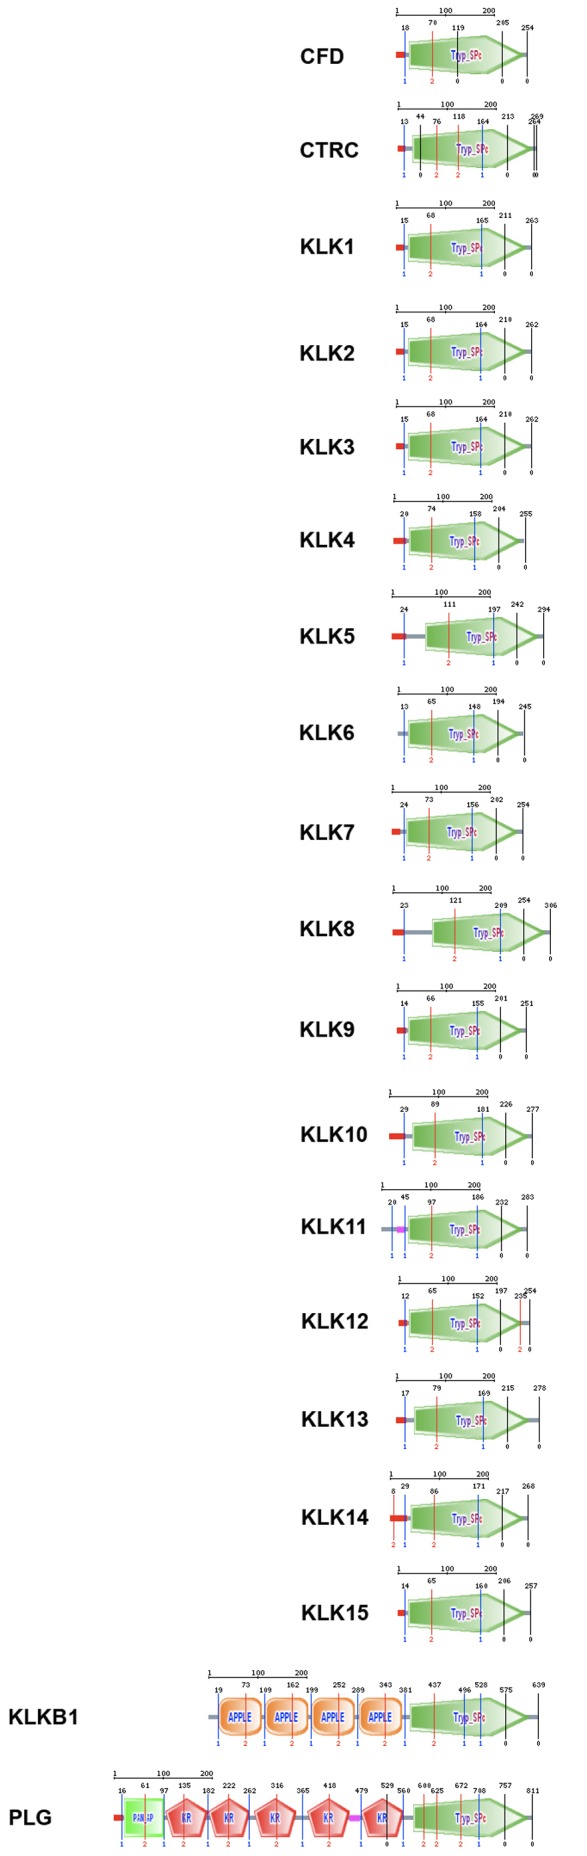
Conserved domains and exon boundaries identified via SMART for the human plasma kallikrein, tissue KLKs, and other serine proteases.All proteins contain a Trypsin-like serine protease domain (green; IPR001254), and most have an N-terminal signal peptide (red). Plasma kallikrein (KLKB1) contains four N-terminal APPLE domains (orange; IPR000177), also found in coagulation factor XII, and mediating protein-protein interactions. Plasminogen (PLG) contains an N-terminal APPLE domain, as well as five Kringle domains (red; IPR000001). Intron positions are indicated with vertical lines showing the intron phase (below) and exact amino acid position (above).